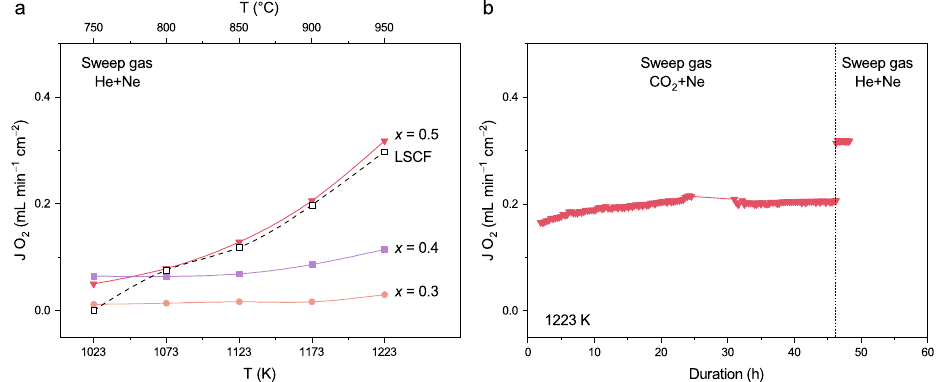
Figure 7. Oxygen flux of Pr 1– x Sr x (Cr,Mn,Fe,Co,Ni)O 3– δ ( x = 0–0.5) membranes as functions of ( a ) temperature and ( b ) duration. Test conditions: 150mLmin − 1 synthetic air as the feed gas, 29mLmin − 1 He or CO 2 as the sweep gas, and 1mLmin − 1 Ne as the internal standard gas.